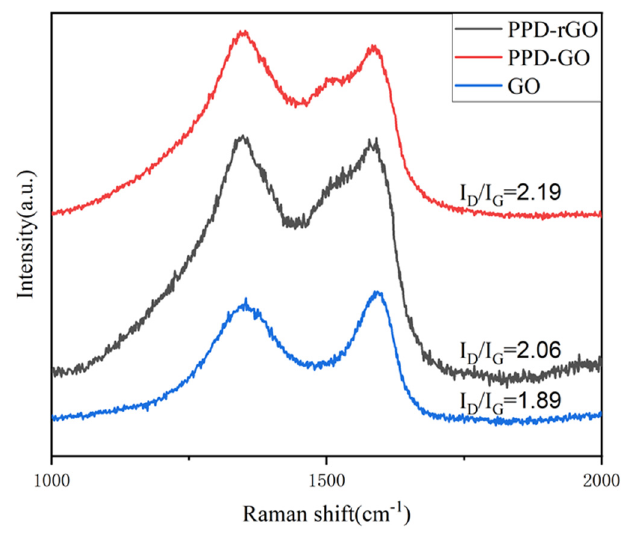
Figure 3. Raman shift of GO, PPD-Go, and PPD-rGO.